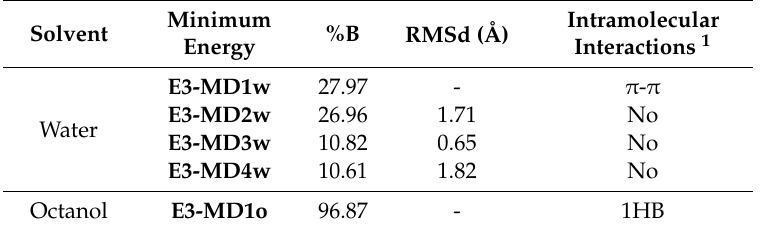
Table 8. %B, RMSd values and intramolecular interactions of the most probable energy minima for E3, obtained after the minimization of all MD frames in both solvents. RMSd values are reported in Å, and they are calculated on the heavy atoms of E3 compared to the global energy minima ( E3-MD1w and E3-MD1o ). Intramolecular Minimum %B RMSd (Å) Solvent Interactions 1 Energy Water